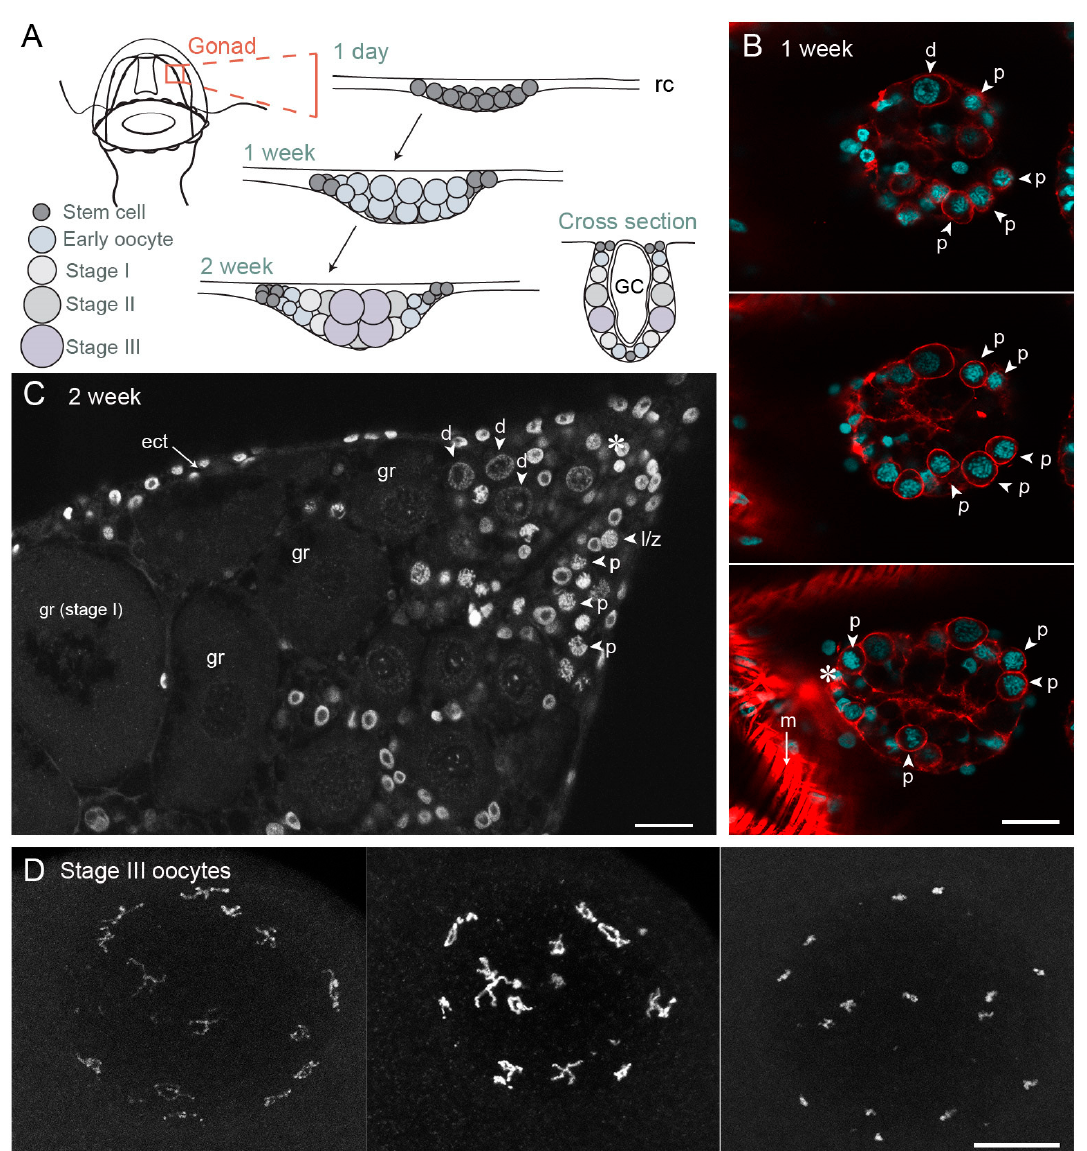
Figure 4. Gonad development and oocyte growth in Clytia hemisphaerica . ( A ) Schematic of gonad development in 1-day jellyfish (newly released from a polyp specialised for budding called the gonozooid), one-week and two-week old jellyfish; ( B ) Confocal image through the gonad of one-week old jellyfish, three different z planes; cyan—Hoechst (DNA), red—phalloidin (actin). In the bottom section, strong phalloidin staining of a surrounding fold of bell muscle is visible (m); ( C ) Gonad of two-week-old jellyfish, single confocal z plane. Grey—Hoechst (DNA). ( D ) Maximum projection of fully-grown Stage III oocytes at different stages of chromatin compaction. The fifteen pairs of homologous chromosomes, linked by chiasmata, are dispersed throughout the nucleus, mostly adjacent to the nuclear envelope. Grey—Hoechst (DNA). Asterix indicates possible stem cells. Arrows indicate di ff erent meiotic stages in early oocytes. Abbreviations: ect—ectoderm, GC—gastric cavity, rc—radial canal, gr—growing oocyte, l / z—leptotene / zygotene stage oocyte, p—pachytene stage oocyte, d—diplotene stage oocyte, m—muscle. Scale bars all 20 µ